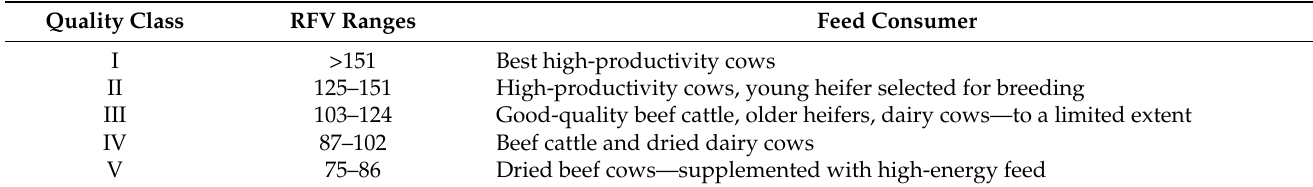
Table 2. Assessment of forage suitability in animal nutrition on the basis of RFV [31]. Quality